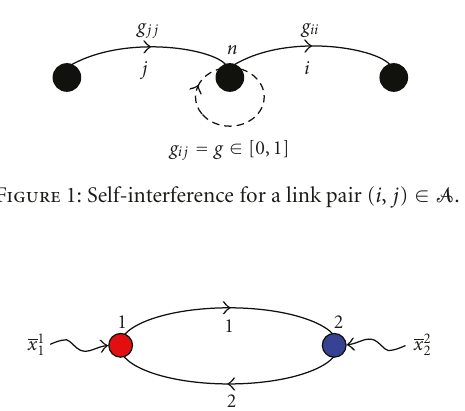
Figure 2: Two-node wireless network with N = 2 nodes, L = 2 links, and S = 2 commodities. Di ff erent commodities are represented by di ff erent